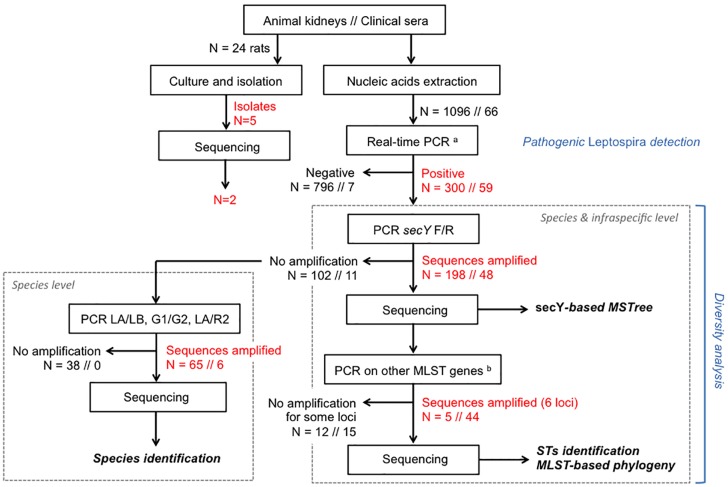
Flow chart of the molecular methods performed to detect and identify Leptospira species and haplotypes infecting samples from Reunion Island.At each step, the number (N) of tested animal samples // clinical samples is indicated. a The real time PCR diagnosis was attempted on either DNA extracted from clinical samples, or cDNA obtained after a reverse transcription step for animal samples. b Six-loci MLST was attempted only for a selected subgroup of the 198 animal samples successfully amplified on secY locus using MLST scheme #3, i.e. eight domestic animals and 17 randomly selected wild small mammals (all Rattus spp).